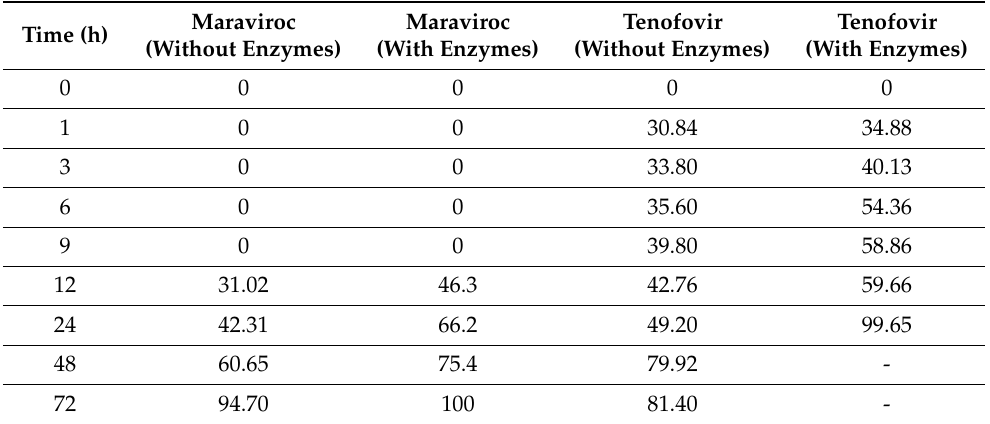
Table 1. Cumulative percentage of drug released from microspheres, with and without acid phos- phatase